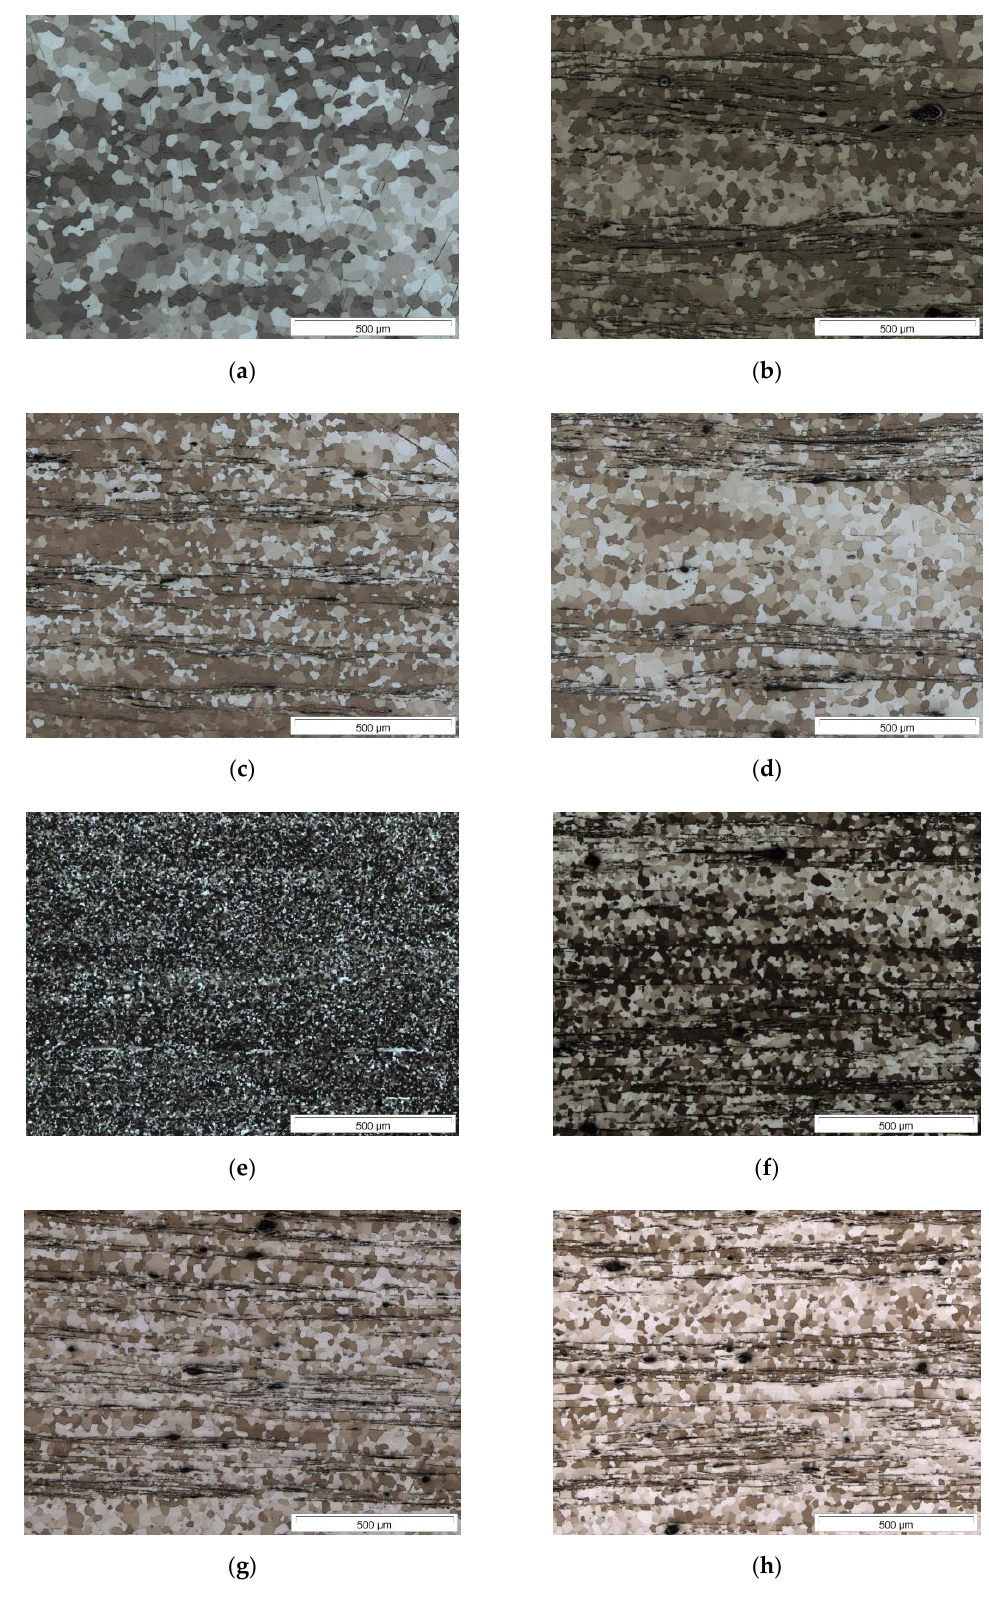
Figure 3. Microstructures from longitudinal sections (extrusion direction → ) of extruded round bars of pure Mg with ( a ) 0, ( b ) 0.75, ( c ) 1.0, and ( d ) 0.5AlN and ZW0303 with ( e ) 0, ( f ) 0.75, ( g ) 1.0, and ( h ) 1.5AlN.